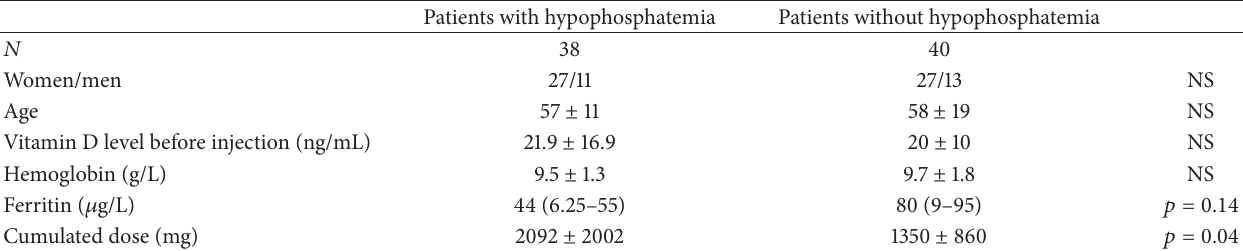
Table 2: Comparison between patients developing hypophosphatemia after FCM injection and patients without